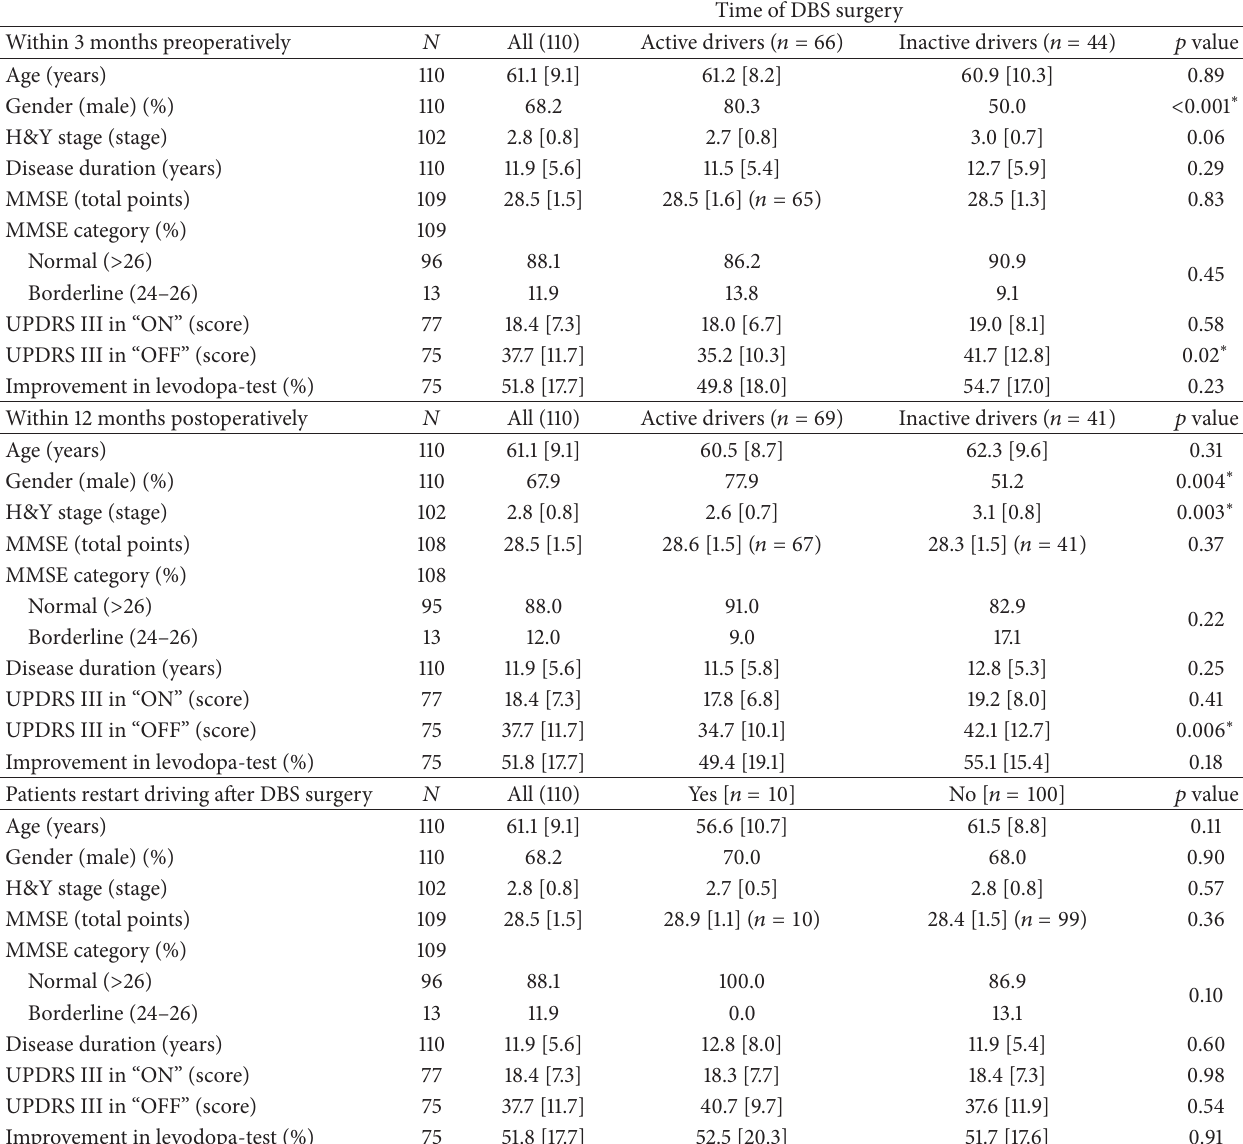
Table 2: The table shows patient characteristics of all drivers and compares patient characteristics of active and inactive drivers at time of DBS surgery (within 3 months before and 12 months after surgery). Furthermore, a comparison of patients who did or did not restart driving is given. Data are shown as means with standard deviation [SD]. Significant different frequencies between active and inactive drivers are labeled with an asterix ( ∗